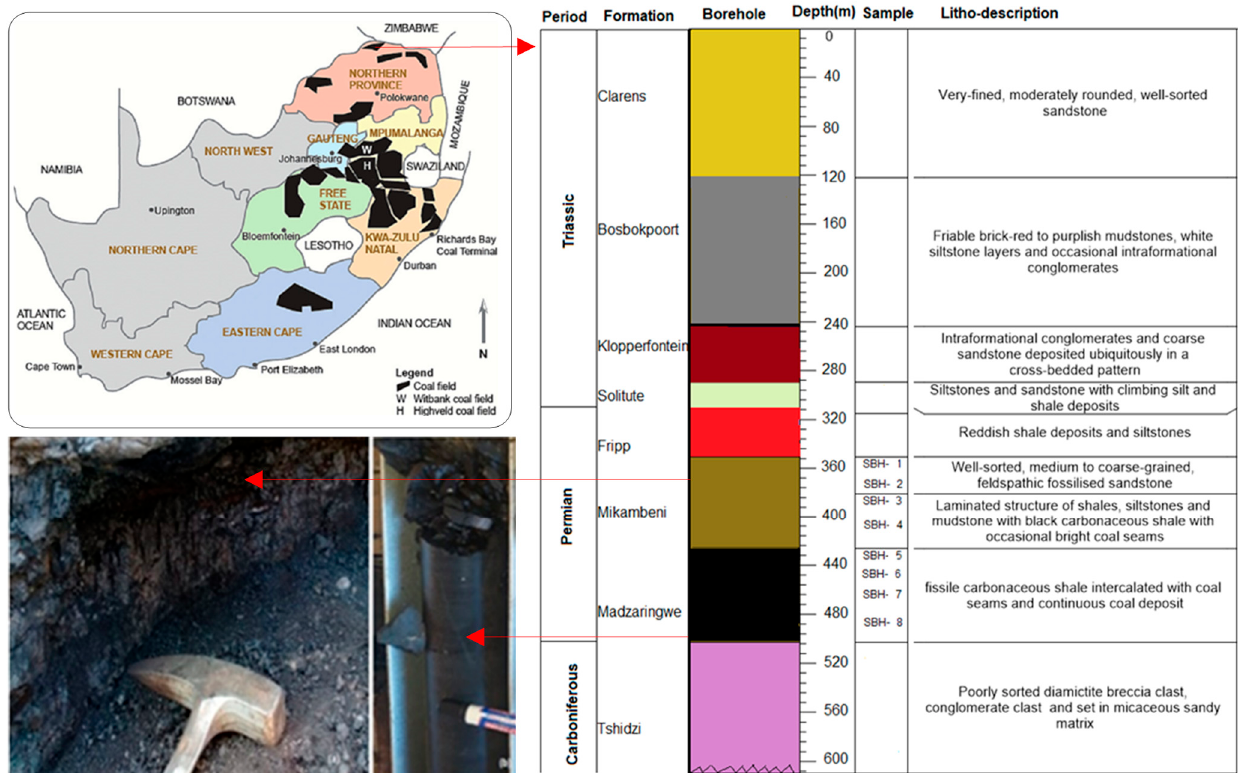
Figure 1. Map and sedimentary sequence of the Tuli Backbulge Basin.